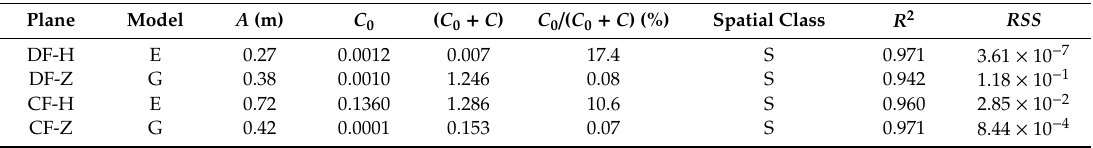
Table 3. Fitted parameters in the semi-variogram models for the dye coverage (DC, %) in horizontal and vertical planes of two types of forest sites.